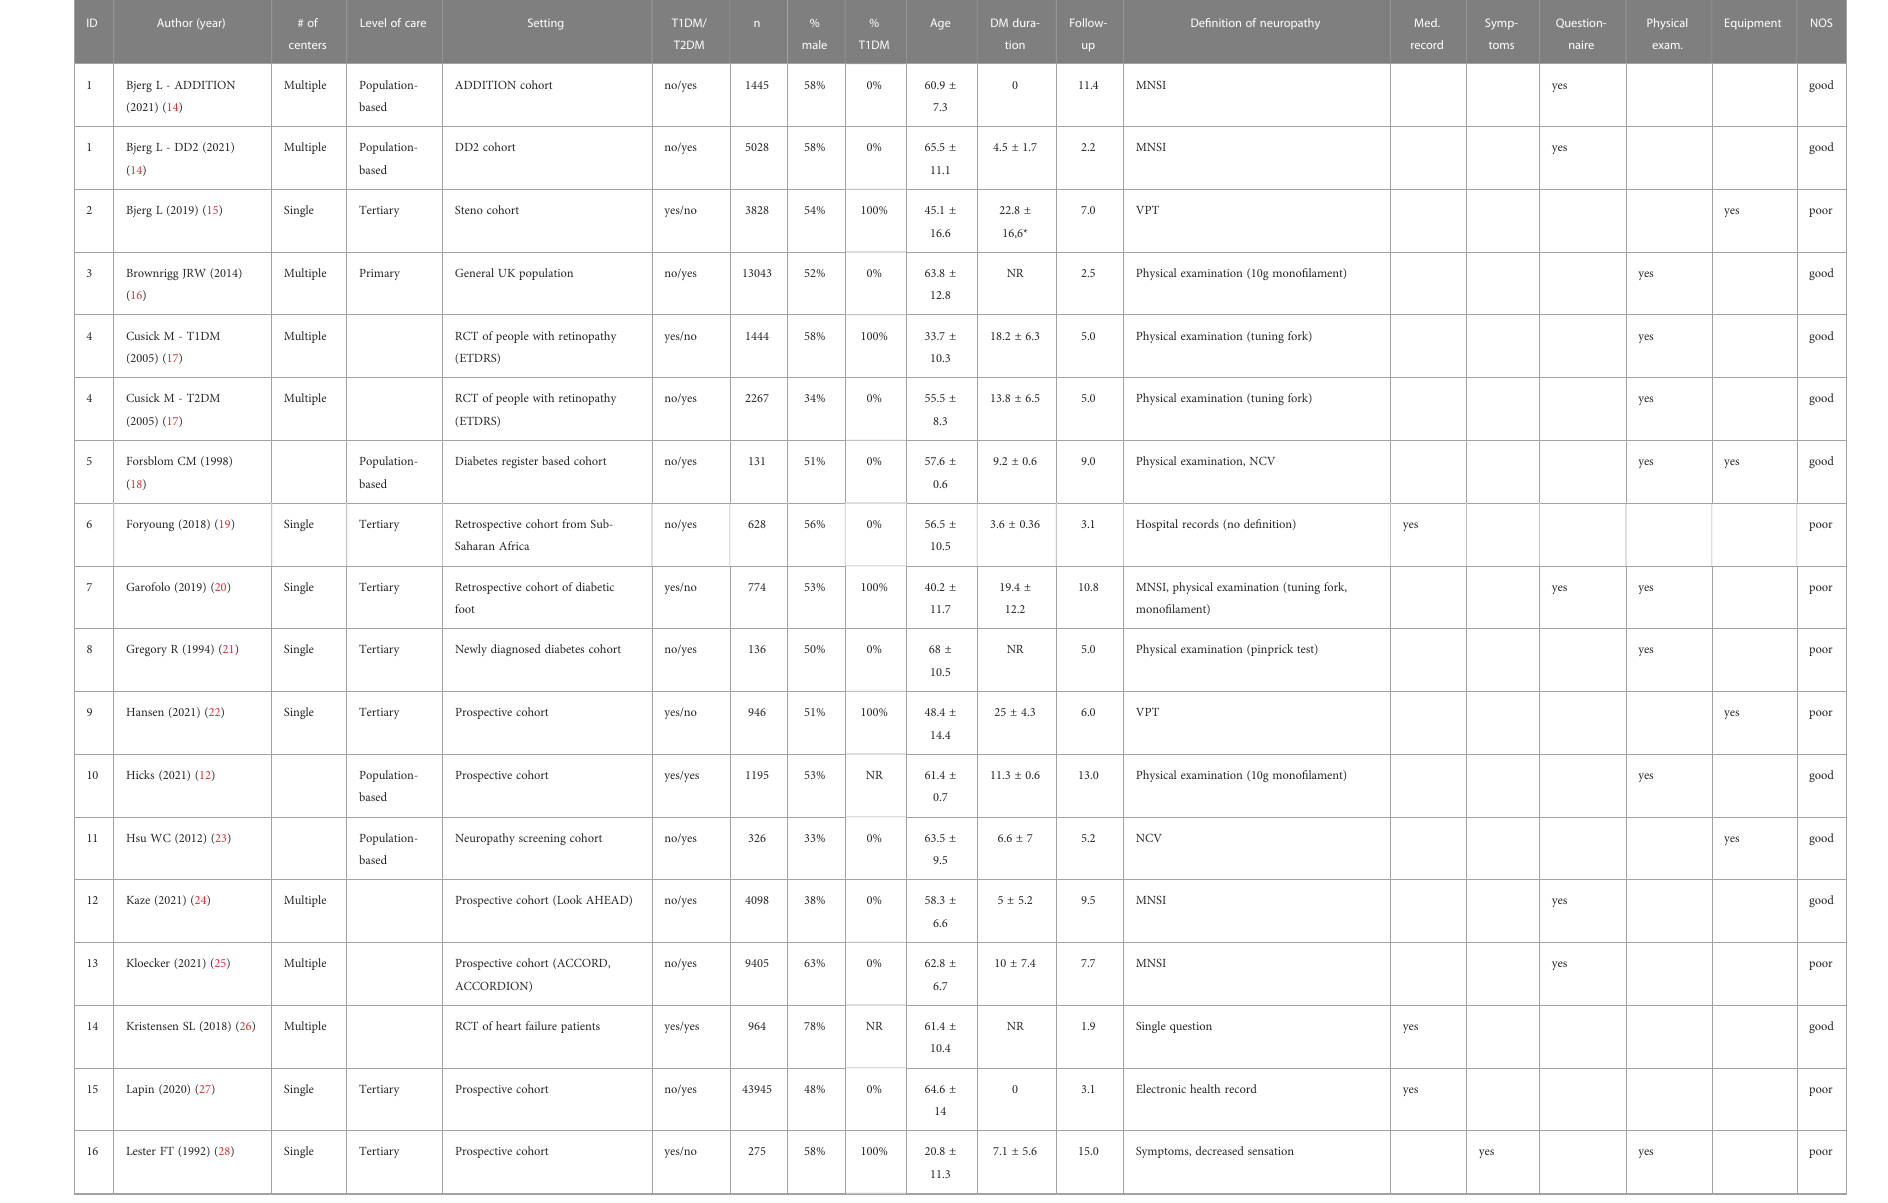
TABLE 1 Baseline characteristics of observational studies included in the meta-analysis on the association between DSPN and all-cause